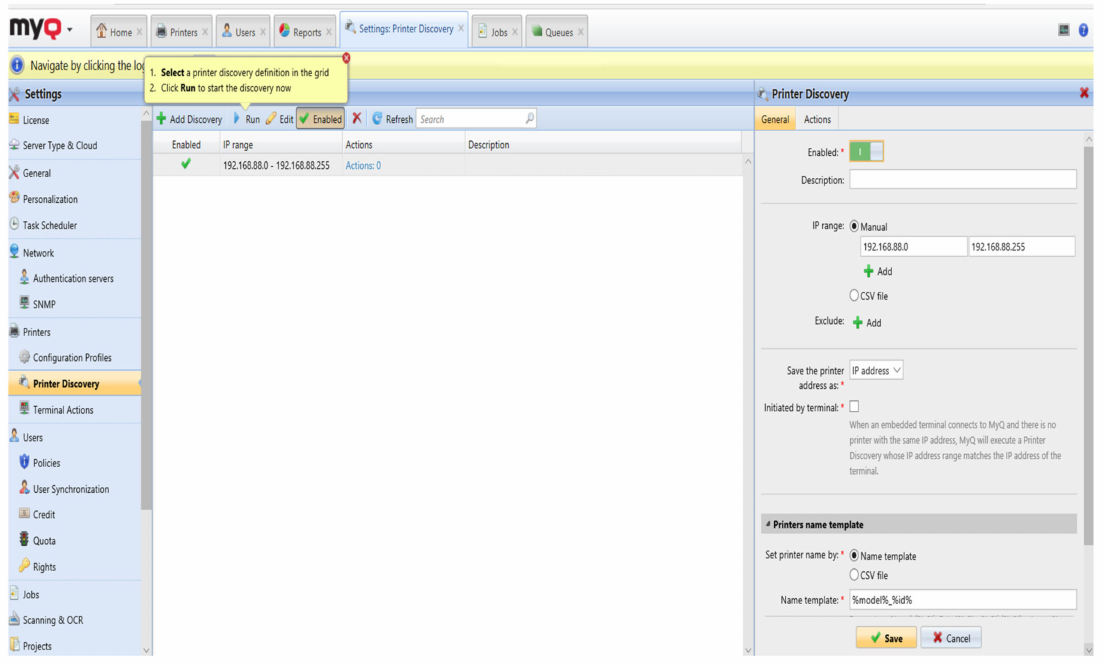
Figure 4. Detecting and searching for new printers via MyQ. Source: custom